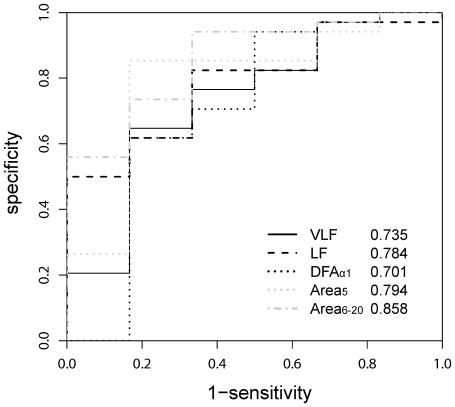
Very-low-frequency component (VLF; black, solid line), low-frequency component (LF; black, dashed line), short-term fractal exponent (DFAα1; black, dotted line), the summations of quantitative values of scale 1–5 (Area5; grey, dashed line), and the summations of quantitative values of scale 6–20 (Area6–20; grey, dash-dotted line) receiver operating characteristic (ROC) curves.The area under each ROC curves (AUC) was calculated for each parameters. The AUCs were 0.735 for VLF, 0.784 for LF, 0.701 for DFAα1, 0.794 for Area5, and 0.858 for Area6–20.